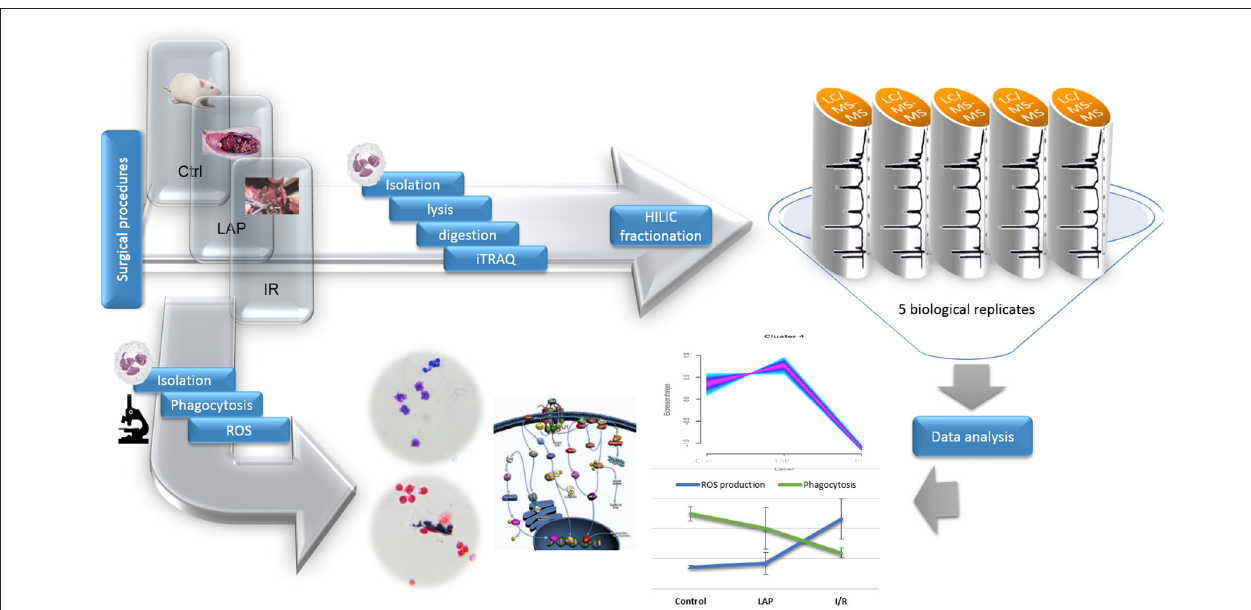
FIGURE 1 | Experimental design. Surgical procedures were followed by isolation of neutrophils from the three conditions. Protein extraction was performed by using FASP protocol. After Hilic fractionations, LTQ Orbitrap MS analysis was performed and the data obtained was analyzed by using bioinformatics tools. Another set of isolated neutrophils was used to determine the phagocytosis rate and ROS production by optical